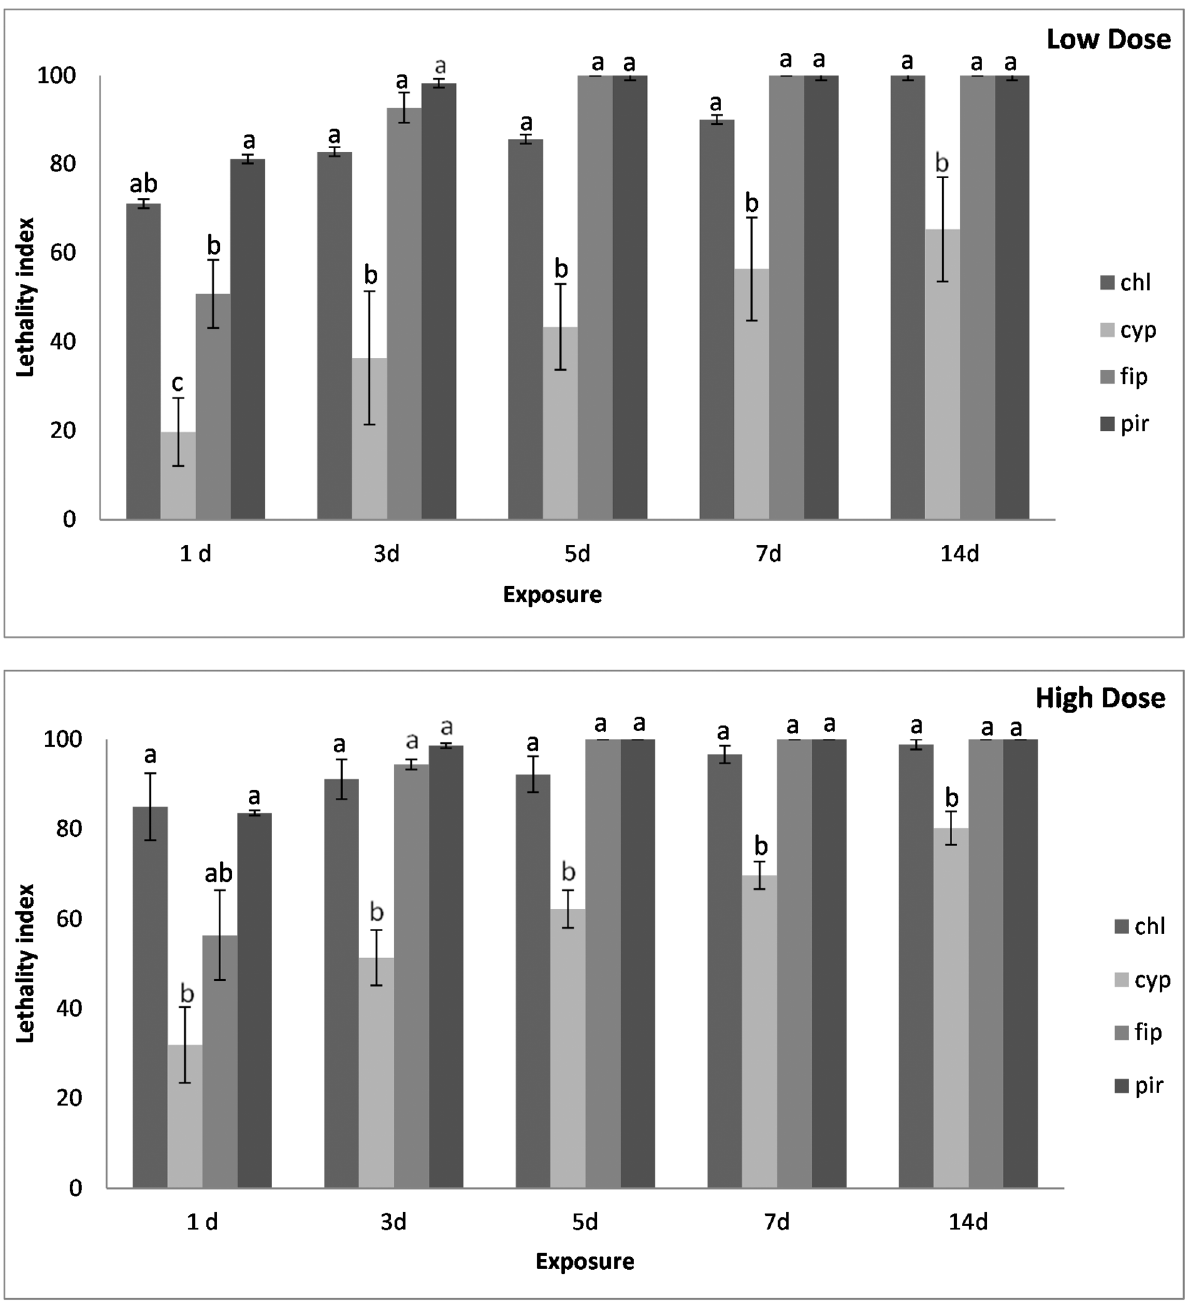
Fig 5. Lethality index of T . confusum adults on concrete surfaces at low and high dose. Mean lethality index ( ± SE) of T . confusum adults on concrete treated with chlorfenapyr (chl), alpha-cypermethrin (cyp), fipronil (fip) and pirimiphos-methyl (pir), at the low and the high dose rate of each insecticide after 1, 3, 5, 7 and 14 d of